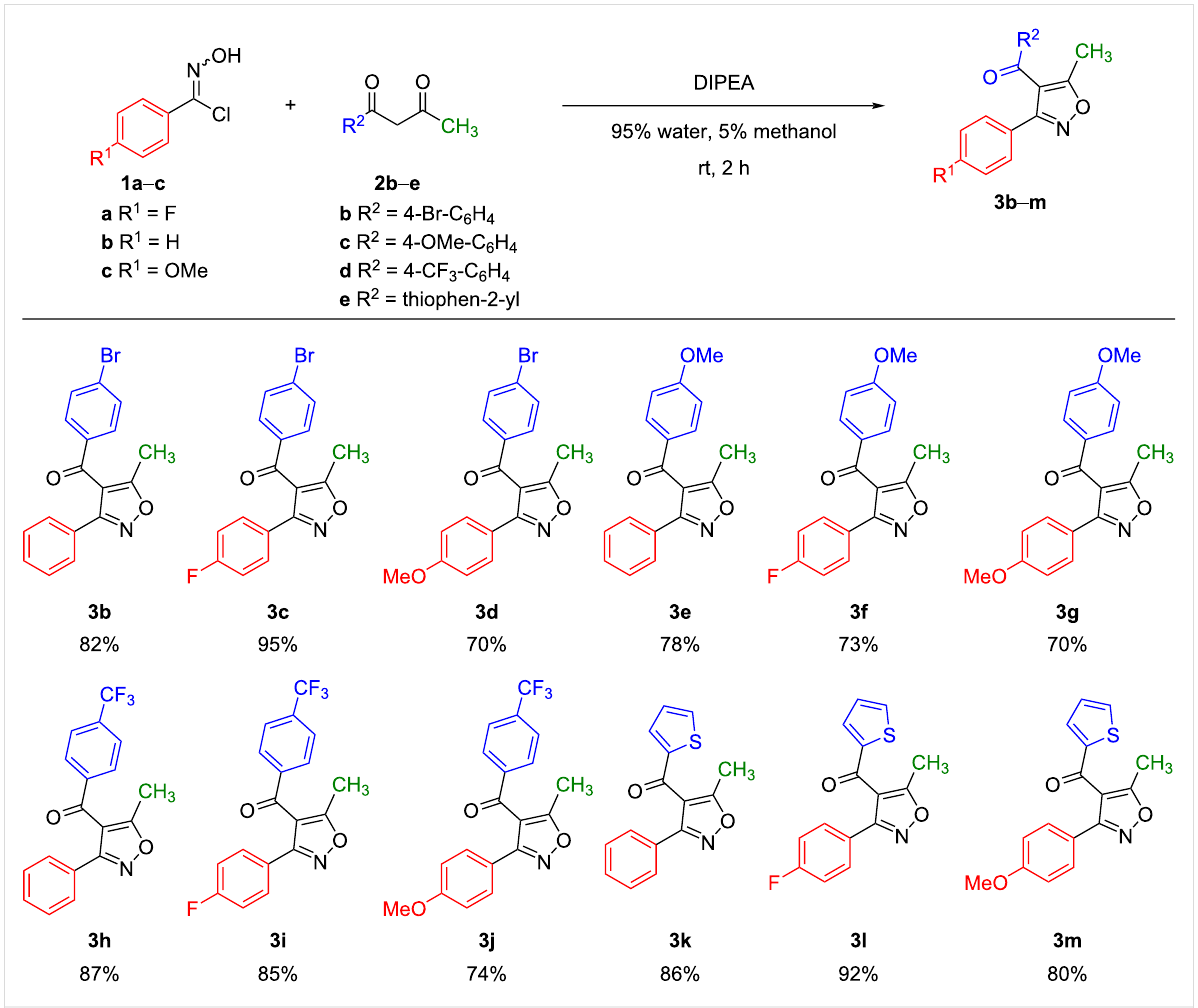
Figure 3: Reactions between various arylhydroximoyl chlorides and 1,3-diketones. The reactions were performed with 0.5 mmol of 1 , 0.5 mmol of 2 , and 3 equivalents of DIPEA in 15 mL of 95% water, 5% methanol at room temperature for 2 hours. The yields were calculated after the isolation and purification of